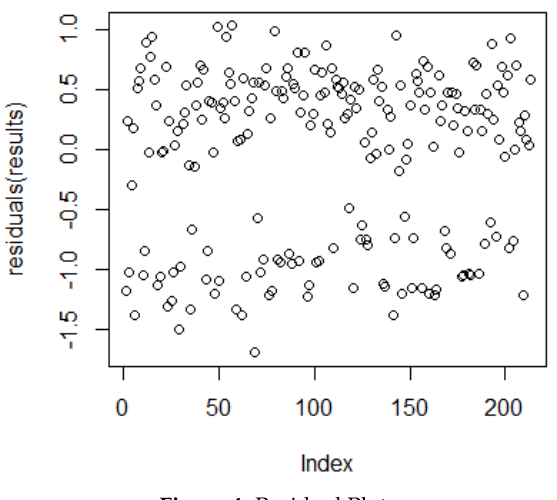
Figure 4. Residual Plot.